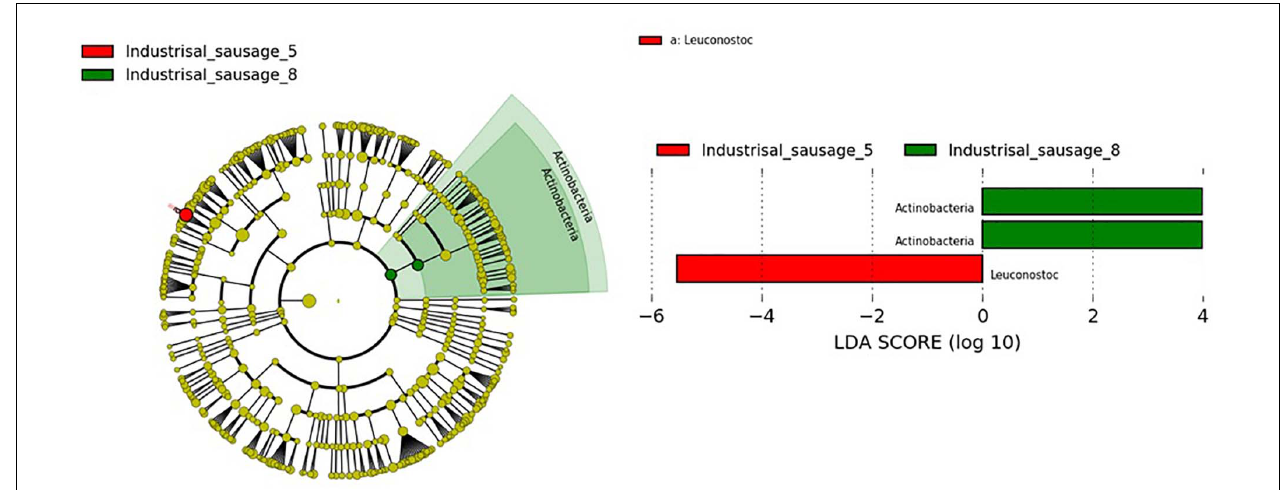
FIGURE 7 | LEfSe analyses of taxon abundances of over-represented bacterial taxa among sausages.